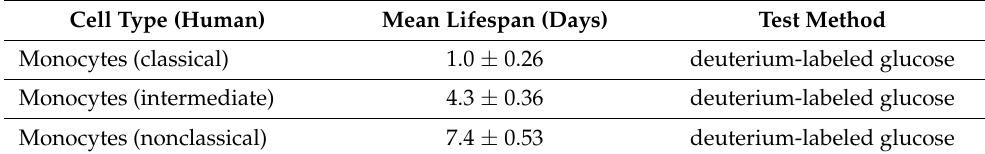
Table 4. Lifespan of human blood monocytes in vivo [31].